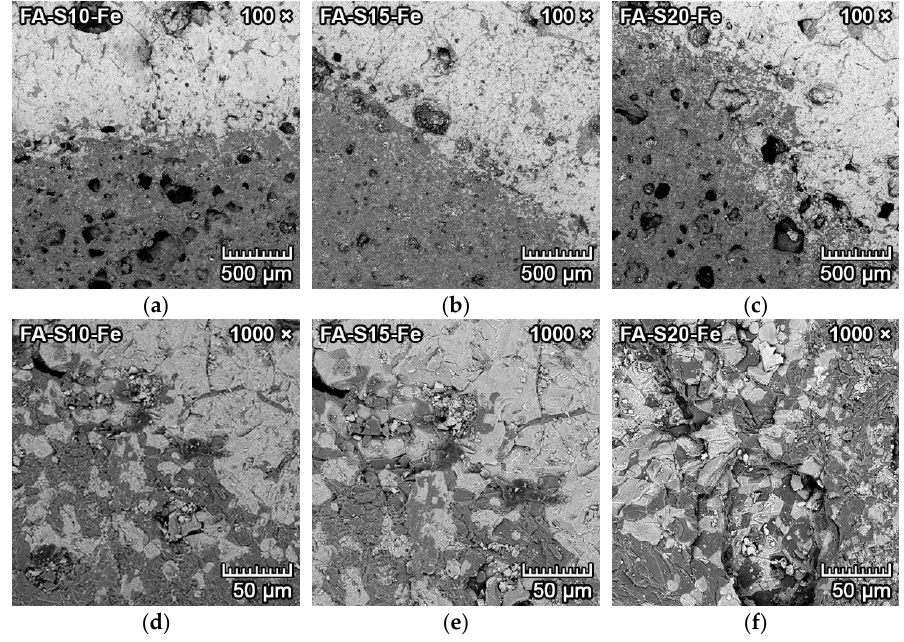
Figure 6. SEM microstructure of the transition zone between iron (light grey) and forsterite – spinel ceramics (dark grey) of fly ash – based mixtures FA-S10, FA-S15 and FA-S20, with a magnification of 100× ( a – c ) and a magnification of 1000× ( d – f ). Figure 6a – f represents the corrosion resistance to iron of samples of fly ash – based mixtures FA-S10, FA-S15 and FA-S20. These samples had an increased porosity in the proximity of the transition zone between iron and ceramics, which was caused by the cre- ation and formation of fayalite (2FeO·SiO 2 ) from iron oxide and an equimolar amount of amorphous silica, according to Equation (3). 2FeO + SiO 2 → 2FeO·SiO 2 . (3) The increase in porosity, which can be seen in Figure 6a – c, was stronger in fly ash – based mixtures, as the amount of the amorphous phase was higher than that of reactive alumina – based mixtures. The higher ratio of flux oxides and mullite decomposition also led to the formation of additional amorphous phase. Due to the higher porosity in the proximity of the transition zone, the EDX probe also detected olivine with a higher con- centration of iron oxide, which diffused more easily into the pore structure. Olivine is a solid solution between forsterite (2MgO·SiO 2 ) and fayalite (2FeO·SiO 2 ), with a general for- mula of (Mg 2+ , Fe 2+ ) 2 SiO 4 . The olivine found in the sample contained 5 – 10% of fayalite, with up to 30% in the proximity of the transition zone. The depth of penetration of iron into the fly ash – based mixtures was 1 – 2 mm, with lower values for mixtures with in- creased content of spinel (FA-S15, FA-S20).